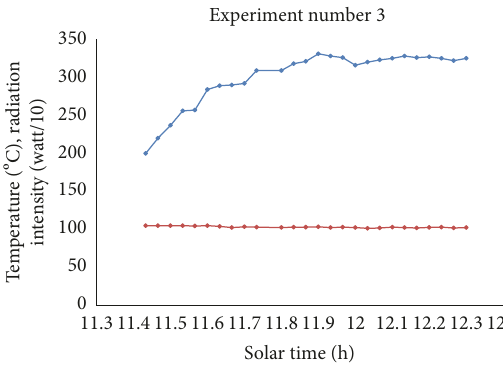
Figure 10: Plot of temperature (blue) and solar radiation intensity (red) versus time for the third unloaded experiment. Radiation intensity is divided by 10 to fi t the